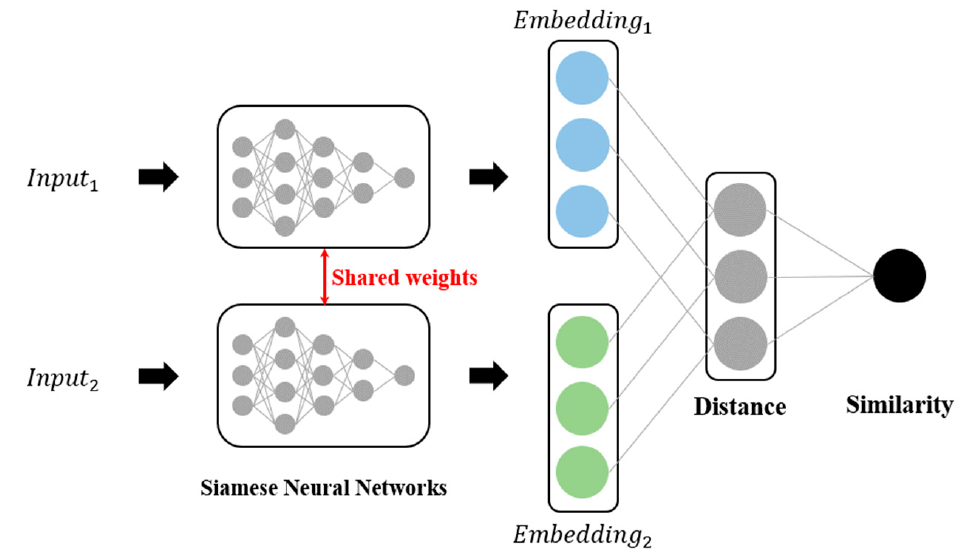
Figure 5. Example of Siamese network architecture.